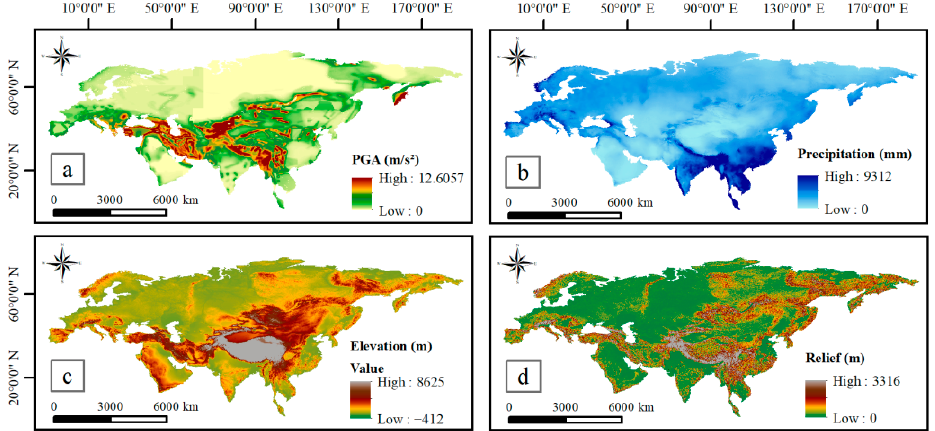
Figure 3. PPR data: ( a ) PGA; ( b ) annual average precipitation; ( c ) elevation; ( d ) topographic relief.